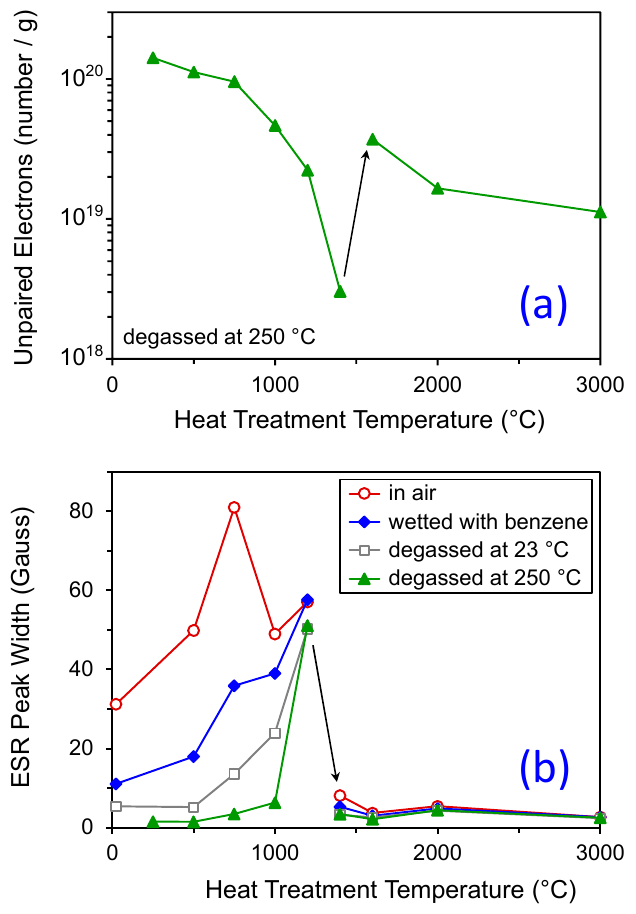
Figure 12. Electron spin resonance results (( a ) unpaired electrons and ( b ) ESR peak width) for medium processing channel (MPC) type of carbon black (Spheron 6 from Cabot; NSA = 111.5 m 2 /g [64]). Results replotted from Kraus et al. [59,60].